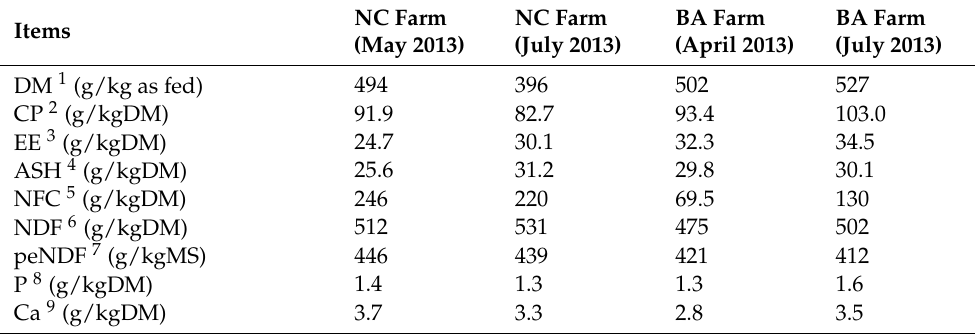
Table 4. Average composition of the diets used in the two feedlots for sire